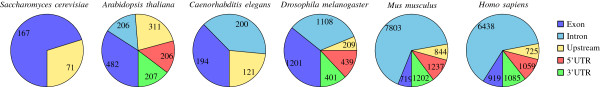
Identification and division of tri-nucleotide repeats in coding regions. Tri-nucleotide repeats in coding regions were identified from genomic scans using Tandem Repeat Finder (see Methods for details). The TNRs are then localised to coding regions according to genomic feature from RefSeq annotations.